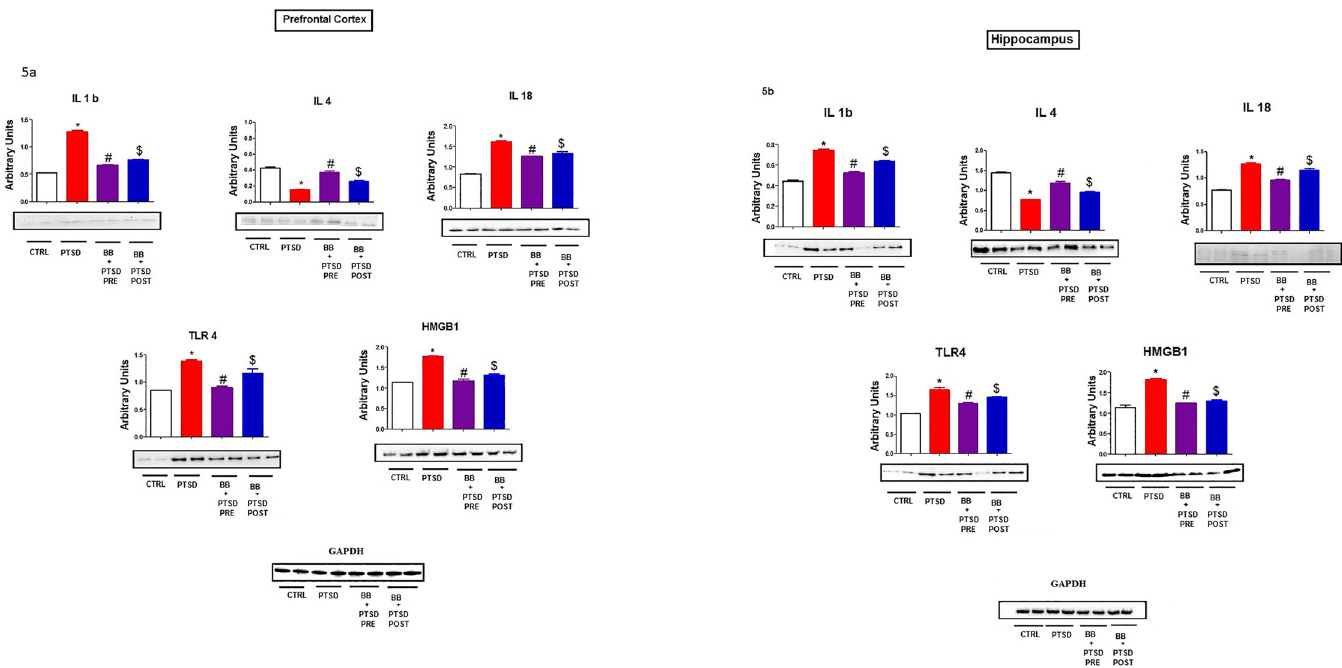
Fig 5. a: Pro and anti-inflammatory Marker Protein: The prefrontal cortex of the PTSD group showed elevated levels (p < 0.05) of IL-1b, IL18, TLR4 and HMGB1. In contrast, the level of anti-inflammatory protein IL-4 were lower (p < 0.05) in the PTSD group. Blueberry enriched diet shows the significant reduction in the levels of proinflammatory cytokines (IL-1b, IL-18) in addition to TLR4 and HMGB1. Statistical analysis was performed using one way ANOVA with repeated measurements followed by Tukey ’ s multiple comparison test. * p < 0.05 Control Vs PTSD, #p < 0.05 PTSD Vs BB = PTSD, and $p < 0.05 PTSD Vs PTSD + BB. All data are presented as mean ± SEM. P < 0.05 compared to control. b: Pro and anti-inflammatory Marker Protein: The Hippocampus of the PTSD group showed elevated levels (p < 0.05) of IL-1b, IL18, TLR4 and HMGB1. In contrast, the level of anti-inflammatory protein IL-4 were lower (p < 0.05) in the PTSD group. Blueberry enriched diet shows the significant reduction in the levels of proinflammatory cytokines (IL-1b, IL-18) in addition to TLR4 and HMGB1. Statistical analysis was performed using one way ANOVA with repeated measurements followed by Tukey ’ s multiple comparison test. * p < 0.05 Control Vs PTSD, #p < 0.05 PTSD Vs BB = PTSD, and $p < 0.05 PTSD Vs PTSD + BB. All data are presented as mean ± SEM. P < 0.05 compared to